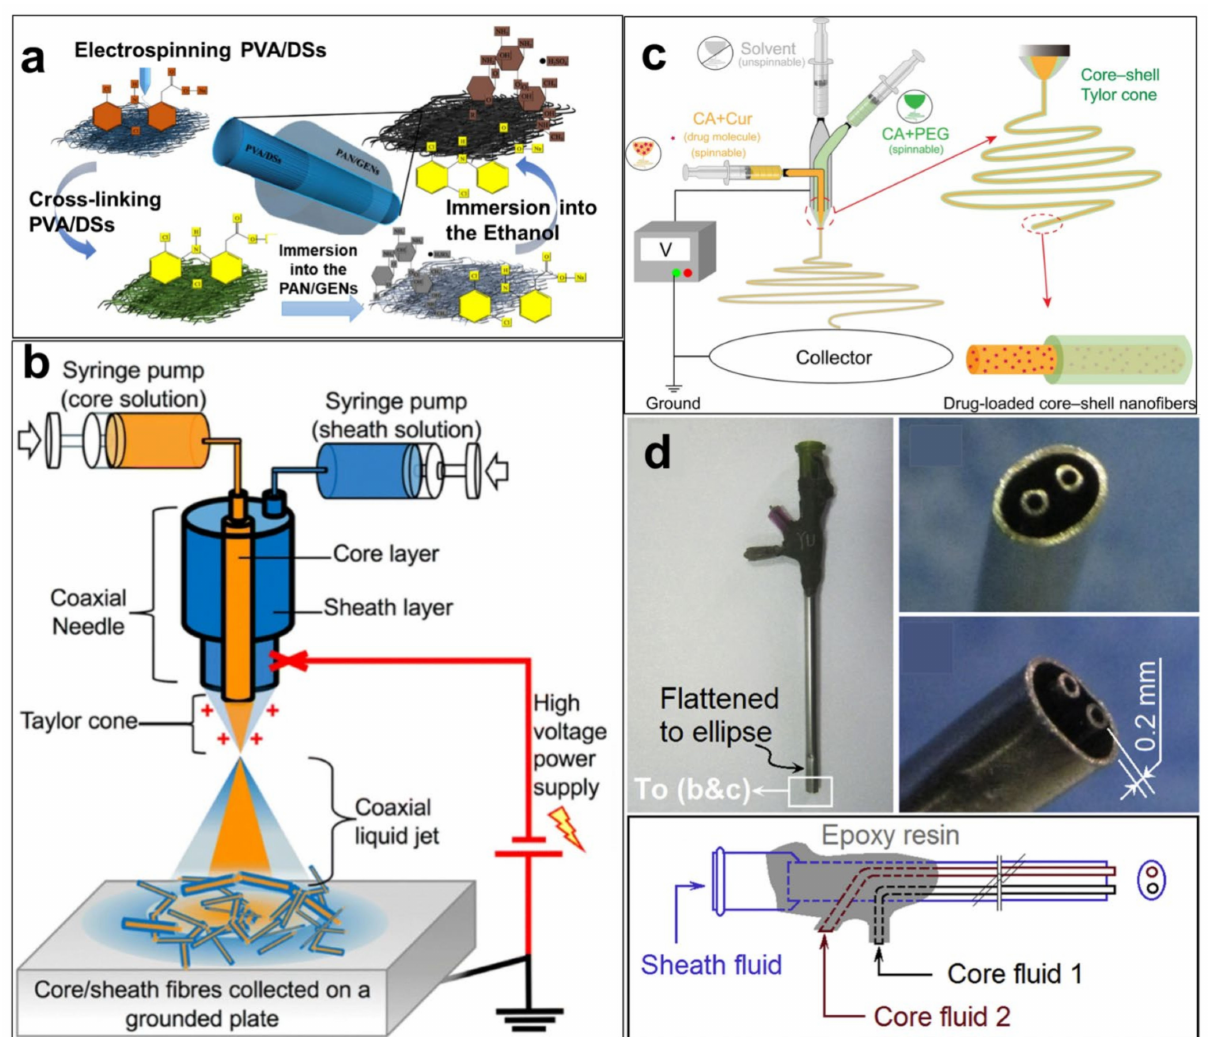
Figure 11. Different preparation methods for wound dressings with core-shell structure. ( a ) Elec- trospinning and dipping method [195]; ( b ) Coaxial electrospinning method, Reprinted with permis- sion from [132] copyright 2020, Springernature. ( c ) Modified triaxial electrospinning method [131]; ( d ) New trifluid electrospinning method, Reprinted with permission from [117] copyright 2020,